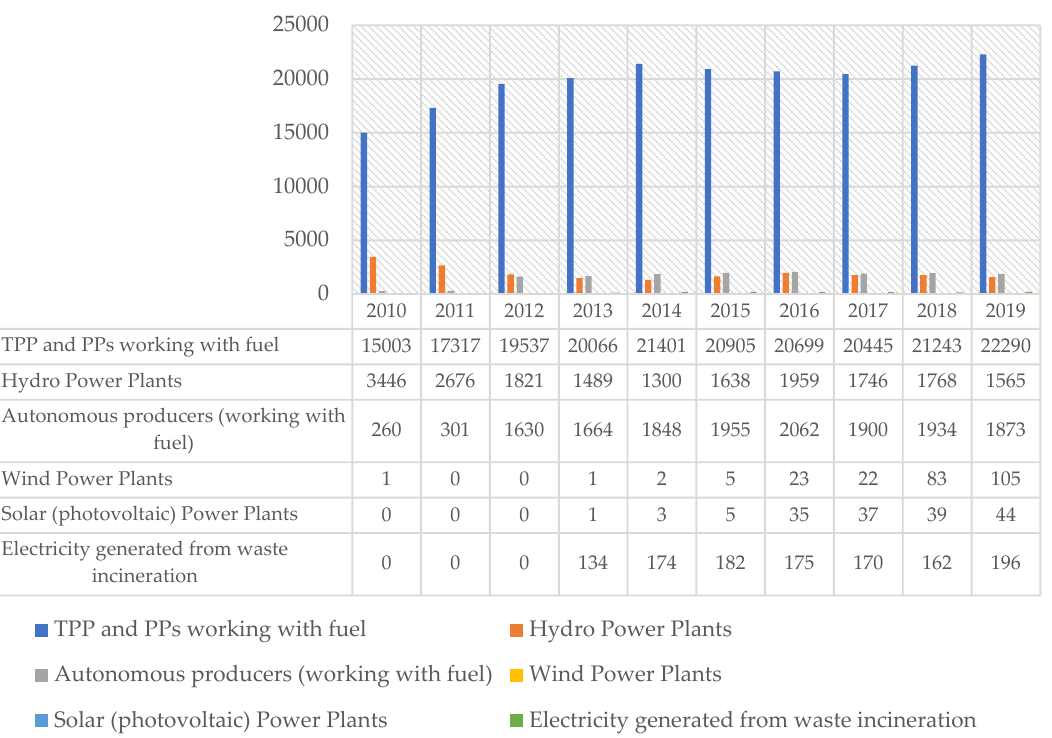
Figure 1. Power generation and types of resources used in Azerbaijan (million kWh) [15].